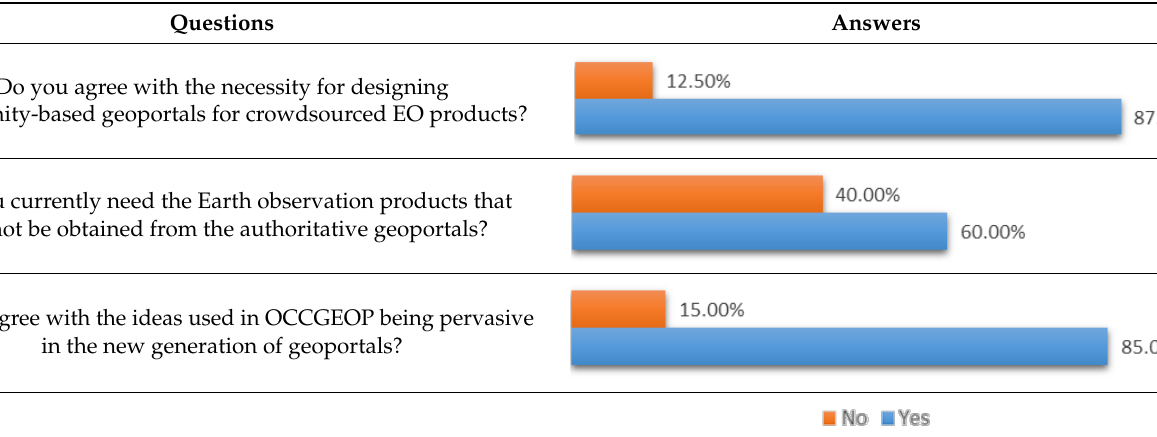
Table 2. Feedbacks of survey participants on the OCCGEOP vision.